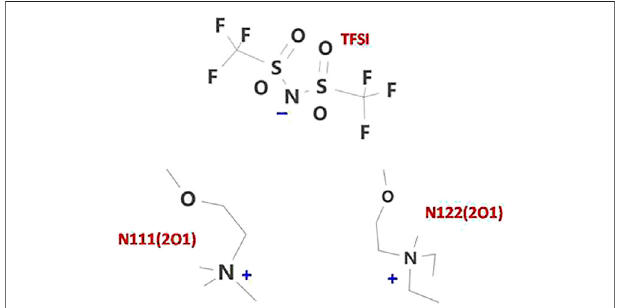
FIGURE1 | Schematic view ofthe TFSI anion and ofthe two N111(2O1) and N122(2O1) cations composing the investigated ILs.